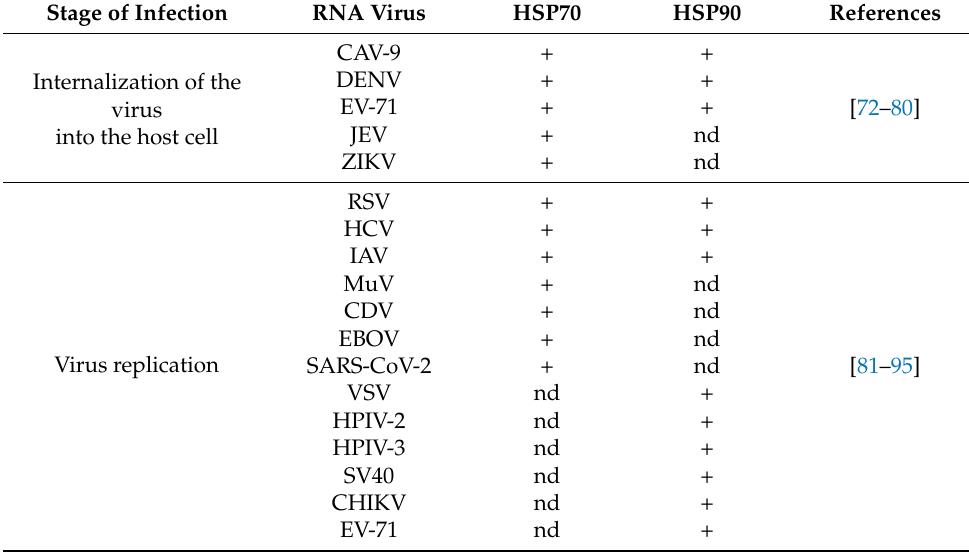
Table 3. Utilization of HSP70 and HSP90 of host cells by RNA viruses at particular stages of infection. Stage of